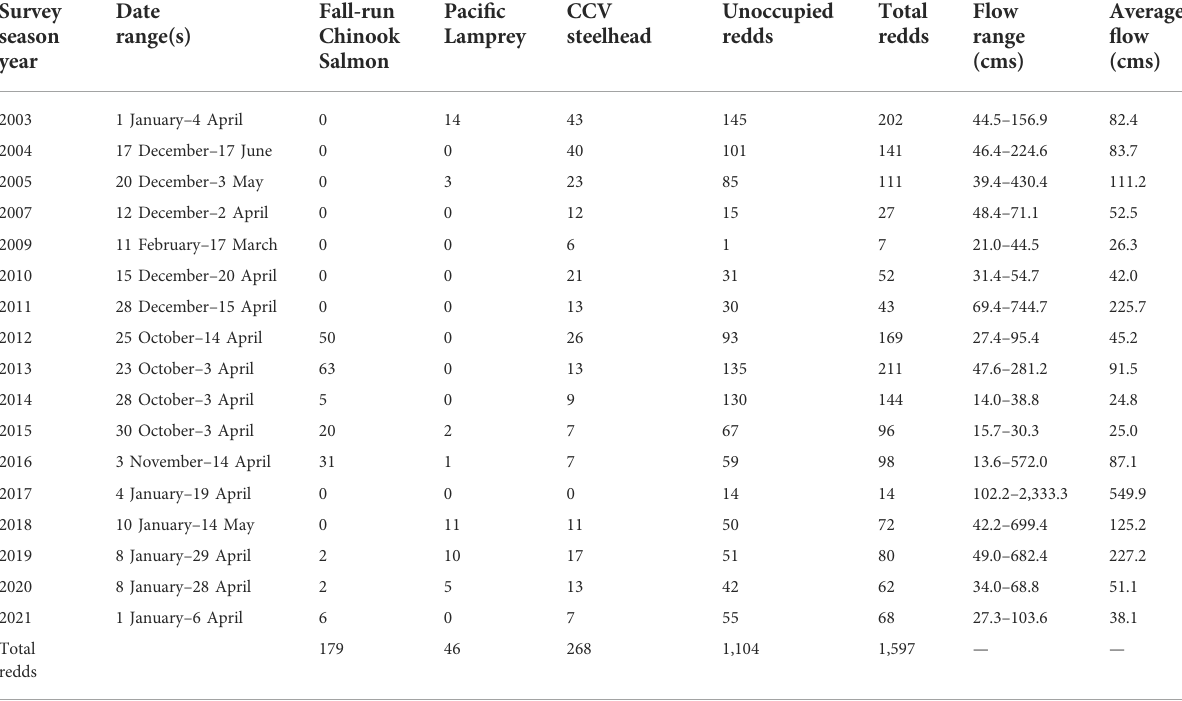
TABLE 1 Summary of redds observed by year and species, and unoccupied redds. The data range when each year of surveys was conducted and the average and range of fl ows during that timeframe is also provided. Insuf fi cient data were available for 2006 and no surveys were conducted in